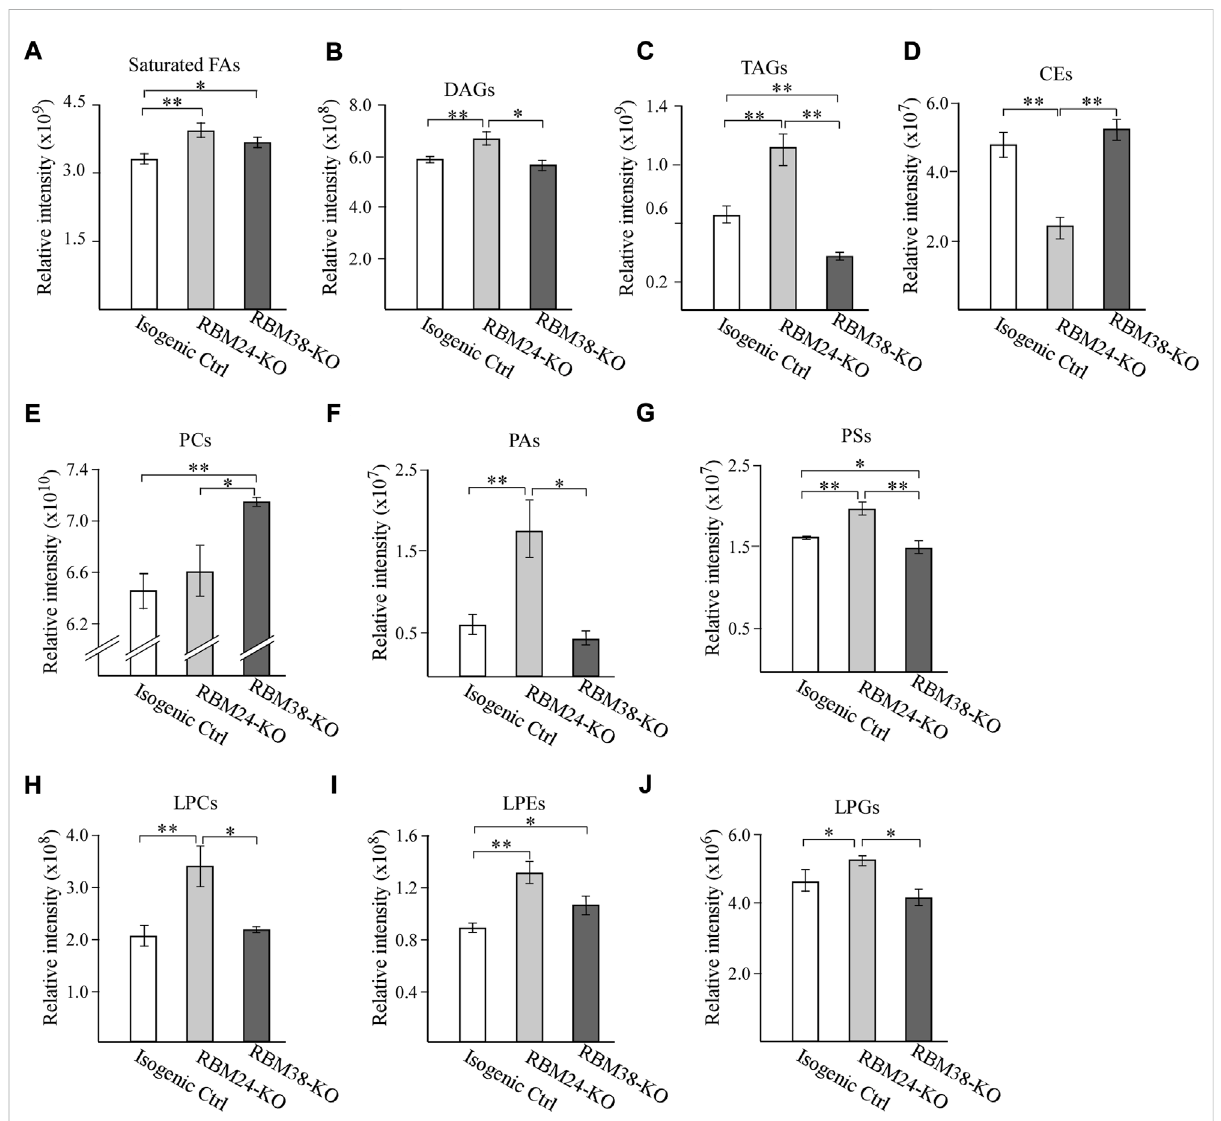
A de fi ciency in RBM24 or RBM38 leads to distinct alterations in lipid pro fi le (A – J) Isogenic control, RBM24 − / − , and RBM38 − / − MCF7 cells were used for lipidomic LC-MS/MS analysis. The relative abundance of a lipid was calculated as mean ± SEM and statistical signi fi cance was determined using Student ’ s t-test. (A) : Saturated Fatty Acids (B) : Diacylglycerols (DAGs) (C) : Triglycerides (TAGs) (D) : Cholesterol esters (CEs) (E) : phosphatidylcholines (PCs) (F) : phosphatidic acids (PAs) (G) : phosphatidylserines (PSs) (H) : lysophosphatidylcholines (LPCs) (I)